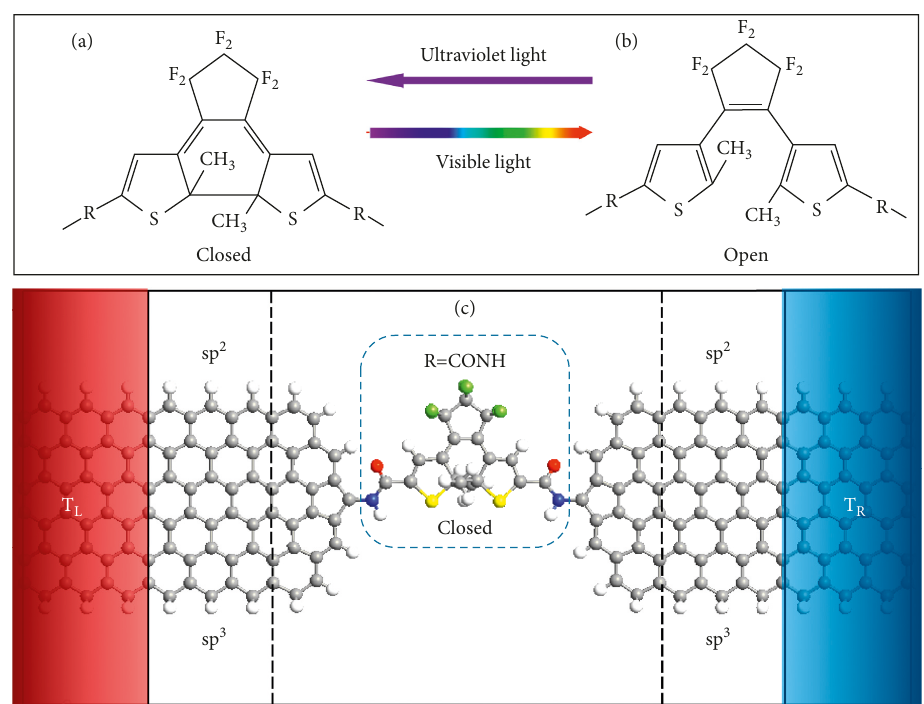
Figure 1: (a) The studied diarylethene derivative frameworks closed and open states. R stands for the functional class that connects the molecule to graphene, equal to CH 2 or CONH. (b) The thermal spin device’s schematic description ( R